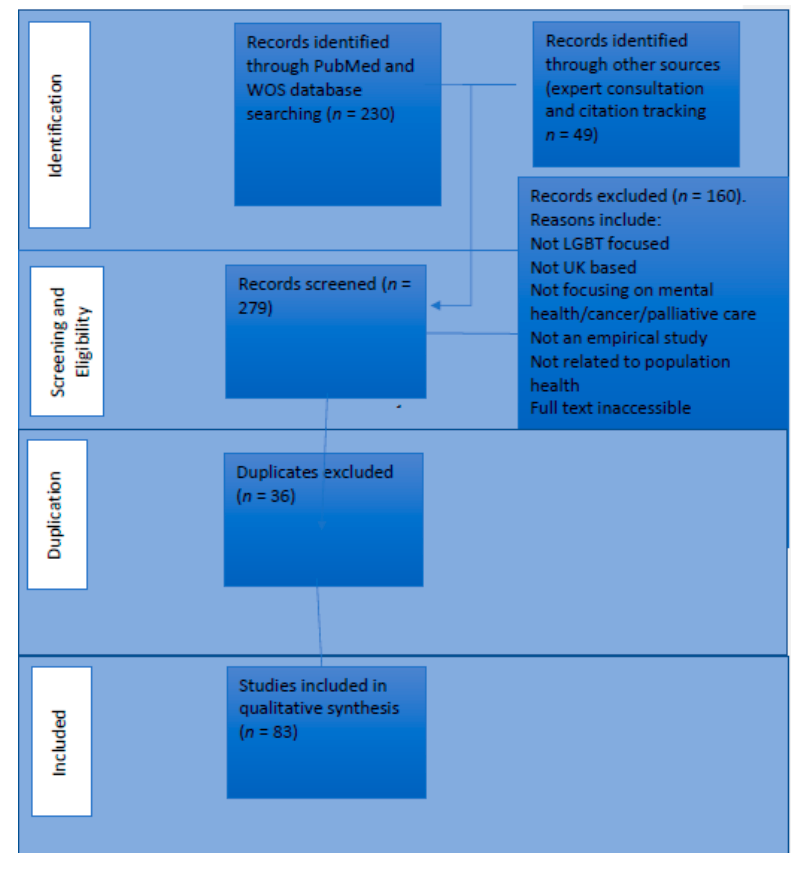
Figure 1. Search results.